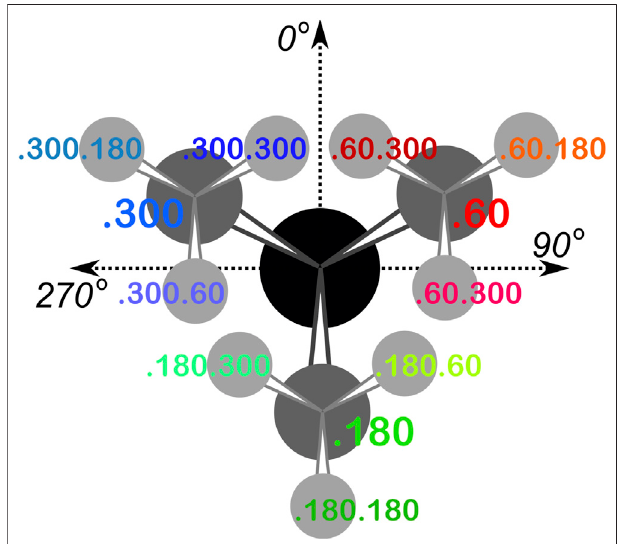
FIGURE 2 | The χ 1 and χ 2 rotamer parses. CB (black) has three χ 1 rotamers (dark gray, CG): 0.60, 0.180 and 0.300. Each of those, for GLU, has three χ 2 rotamers (light gray, CD), as